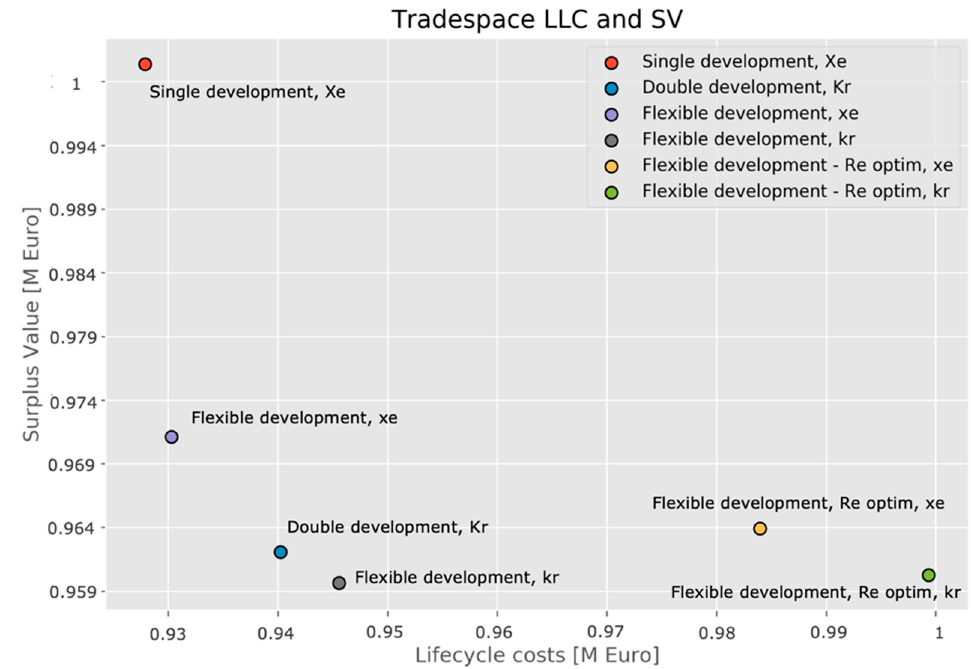
Figure 6. Tradespace between lifecycle costs (LCC) and SV for the different options, considering Market 1. The data regarding SV and LCC have been normalized to preserve company sensitive information.